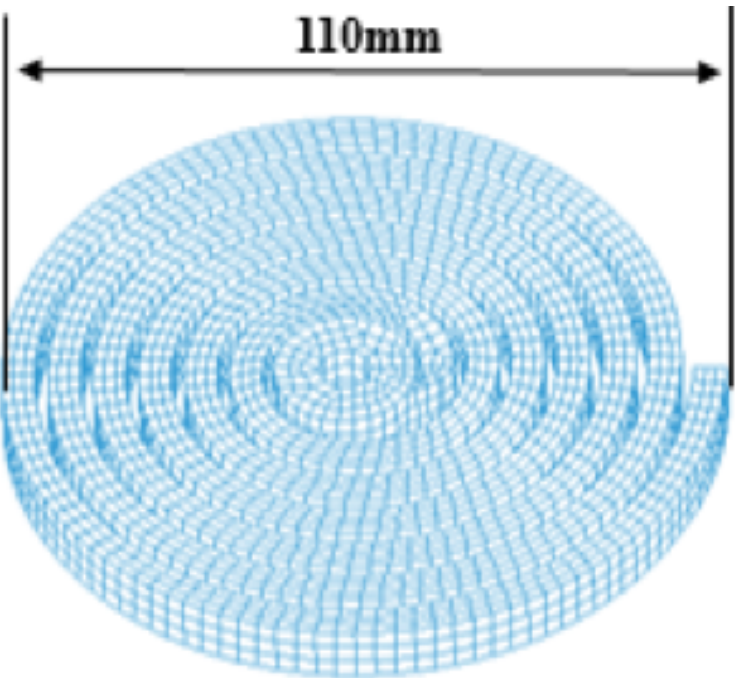
Figure 7. Forming coil model.